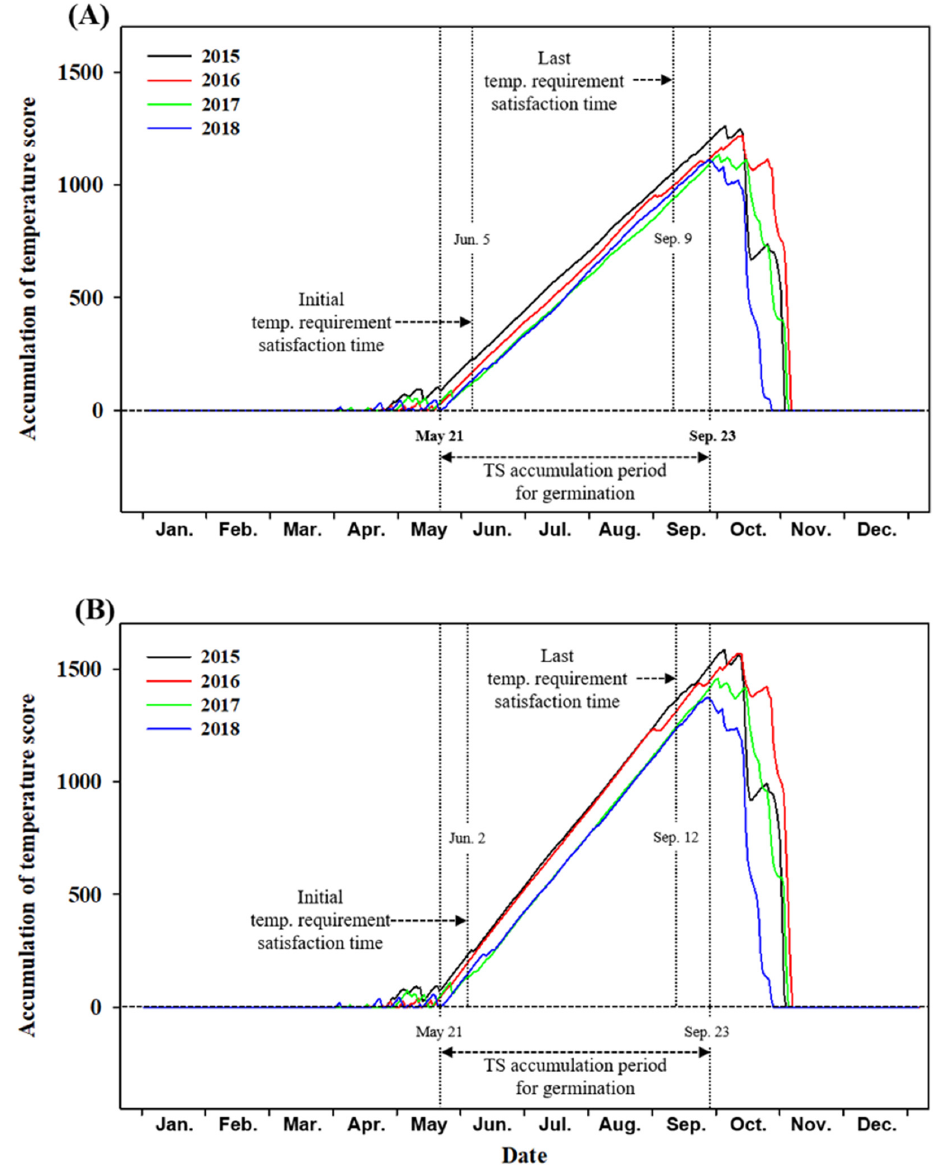
Figure 4. Temperature score (TS) accumulation patterns of Agastache rugosa ( A ) and Astilbe rubra ( B